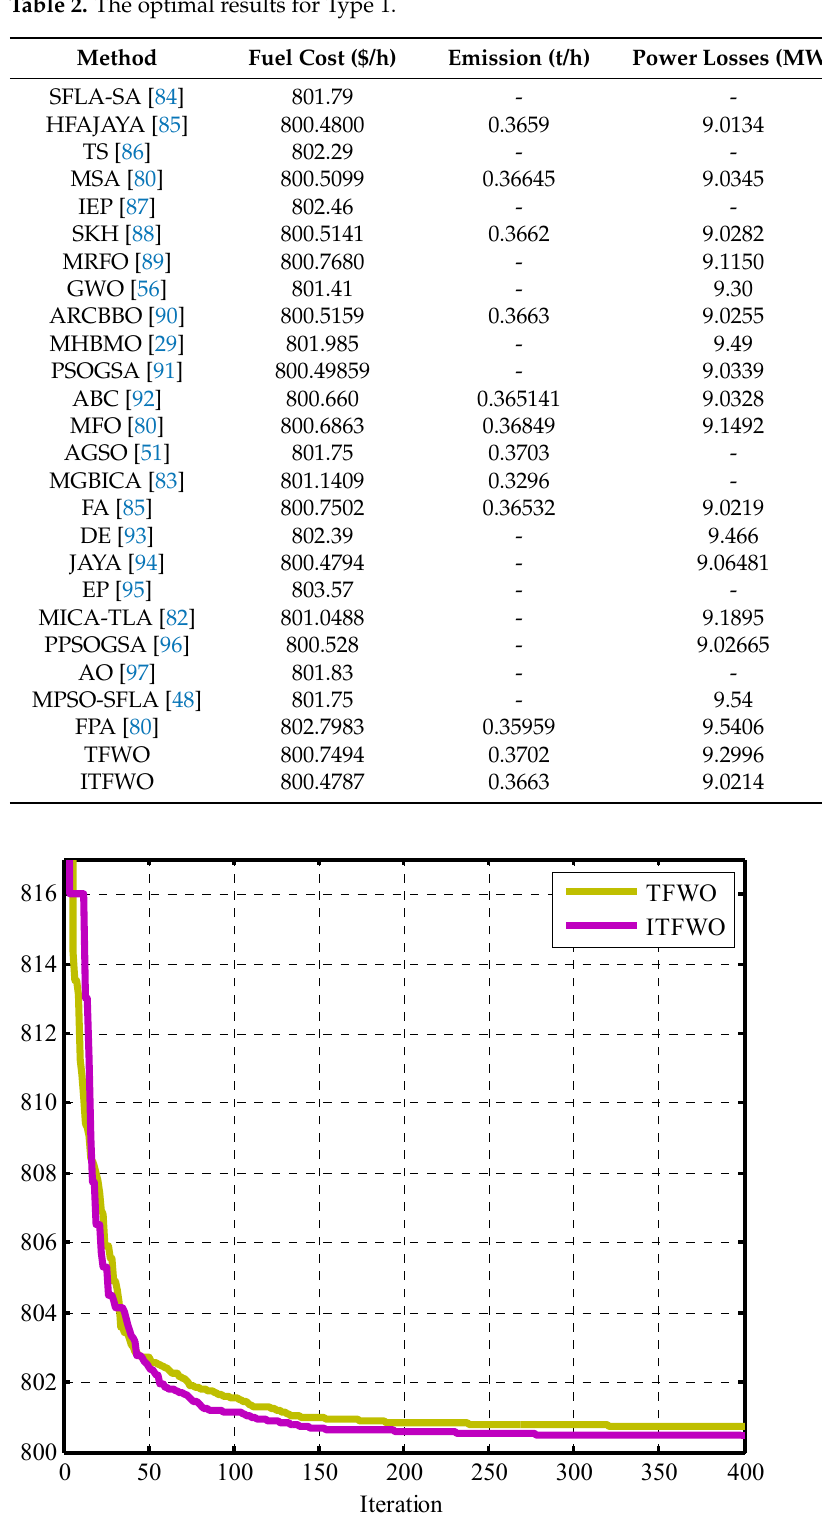
Table 2. The optimal results for Type 1.